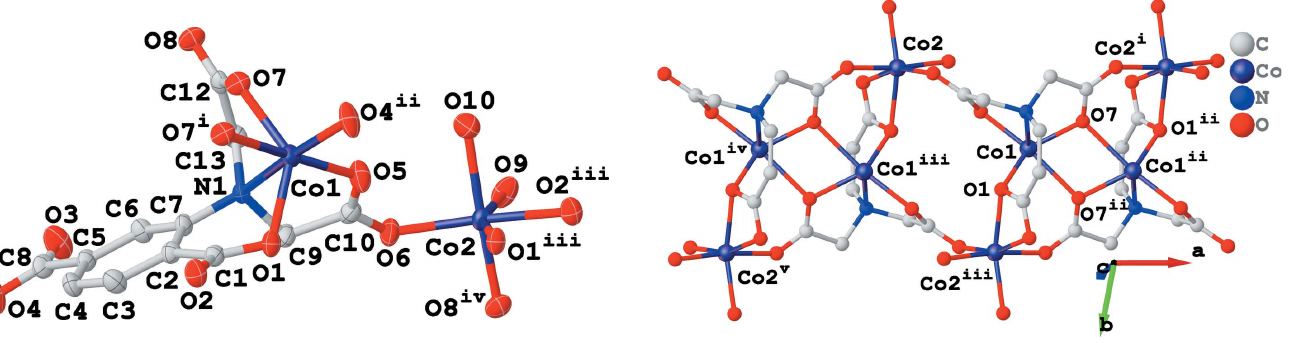
Figure 1 Coordination environments of the Co II ions in ( I ) with displacement ellipsoids drawn at the 50% probability level; H atoms and the disordered lattice water molecules have been omitted for clarity. Symmetry codes refer to Table